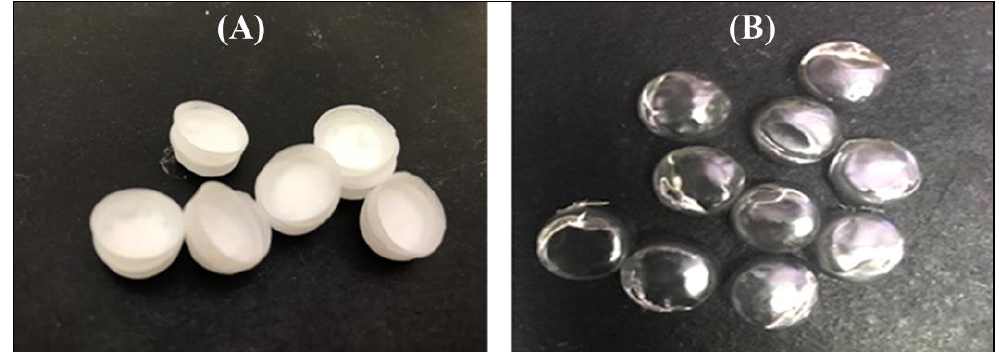
Figure 1. Digital photograph of ( A ) drug loaded and ( B ) placebo orodispersible film formulation.